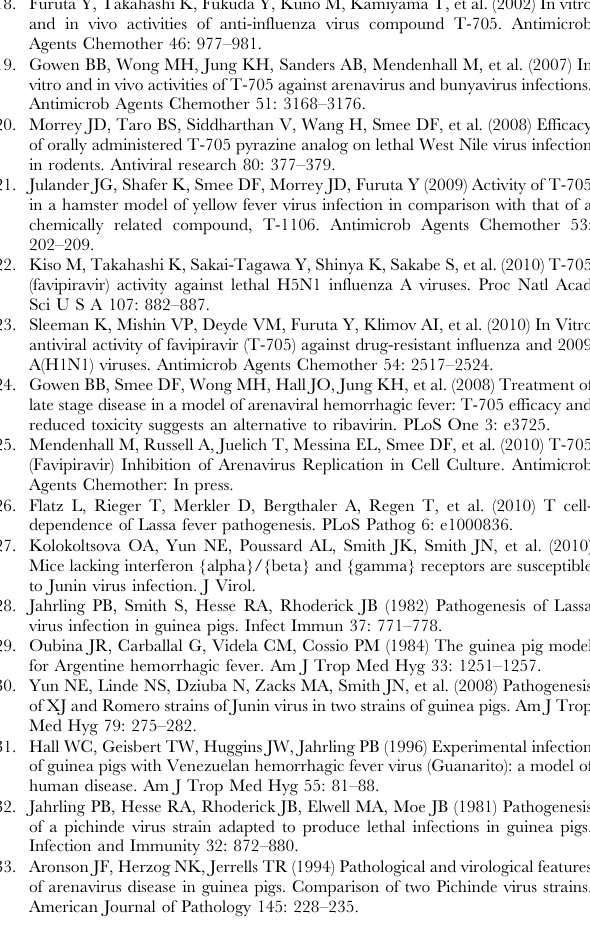
Table S2 Blood chemistry profile during PICV infection in guinea pigs a . a Groups of guinea pigs (n= 3) were sacrificed daily through the course of PICV infection and whole blood was collected for blood chemistry analysis. b The day-10 group (n= 4) included a moribund guinea pig from the day-11 group. c The day-11 group consisted of 2 guinea pigs. d Serum AST was significantly higher on day 10 compared to day 1 ( P , 0.05). e Serum ALB was significantly lower on days 9 and 10 compared